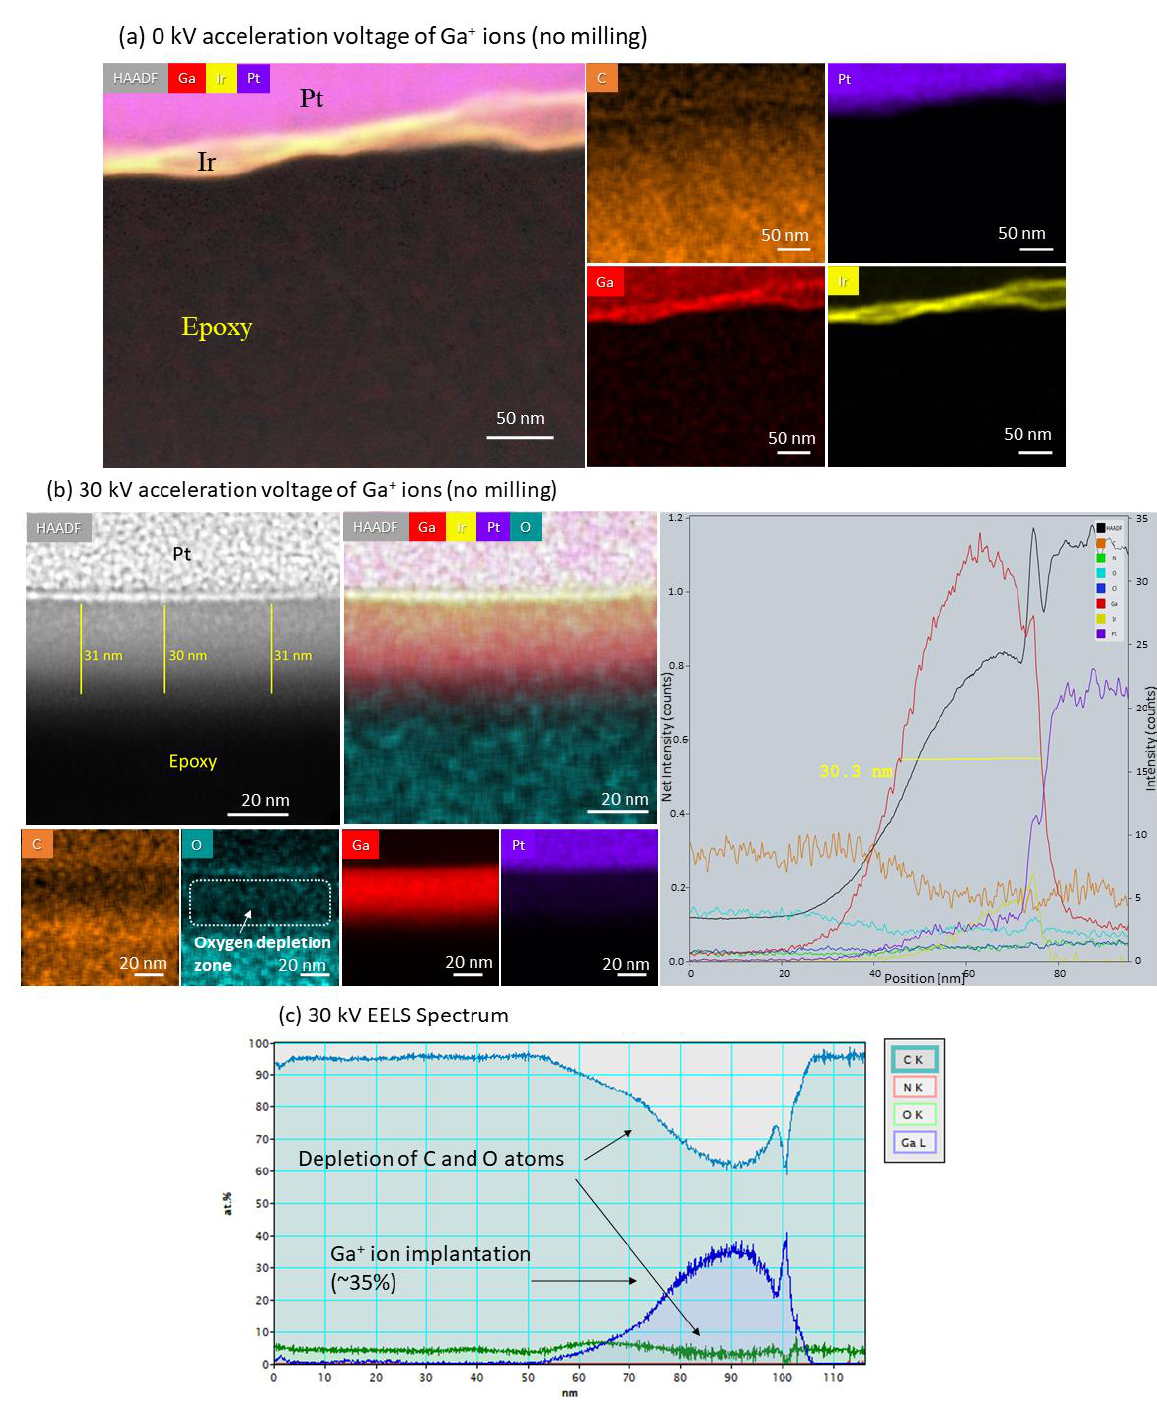
Figure 3. HAADF–STEM imaging and analysis of Ga + ions damage on epoxy. ( a ) 0 kV acceleration voltage of Ga + ions (no milling)—HAADF–STEM image and corresponding EDS elemental distribution map of iridium (yellow), platinum (purple), carbon (orange), and gallium (red). ( b ) 30 kV acceleration voltage of Ga + ions—( left ) HAADF–STEM image and corresponding EDS elemental distribution map of oxygen (blue), platinum (purple), carbon (orange), and gallium (red). Note the gallium layer thickness of 30 nm and depletion of oxygen in that layer. ( Right ) EDS spectrum of 30 kV—intensity counts of each element according to the position (nm). It also measures 30 nm thickness of gallium layer. ( c ) EELS results (line scan) of 30 kV—atomic percentage of carbon, gallium, oxygen, and nitrogen. The figure shows high implantation amount of Ga and a reduction in the atomic percentage of O and C in the same area. Note: the peak at 100 nm is artificial due to stitching of the